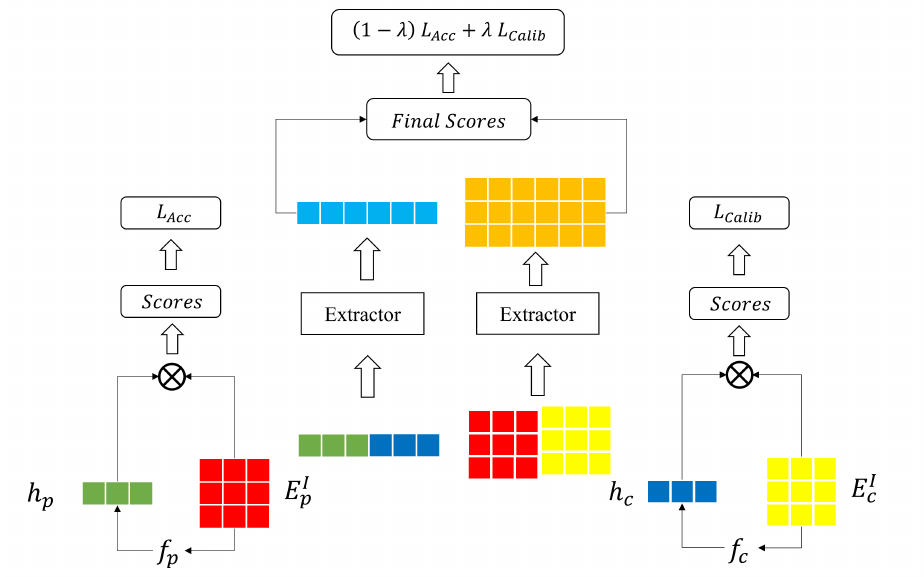
Figure 2. The architecture of our DACSR